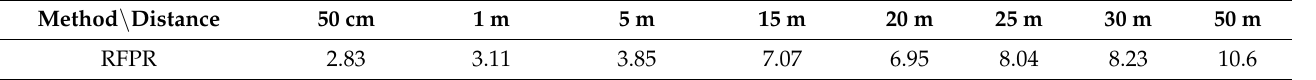
Table 5. MAPE (%) of the FHR according to